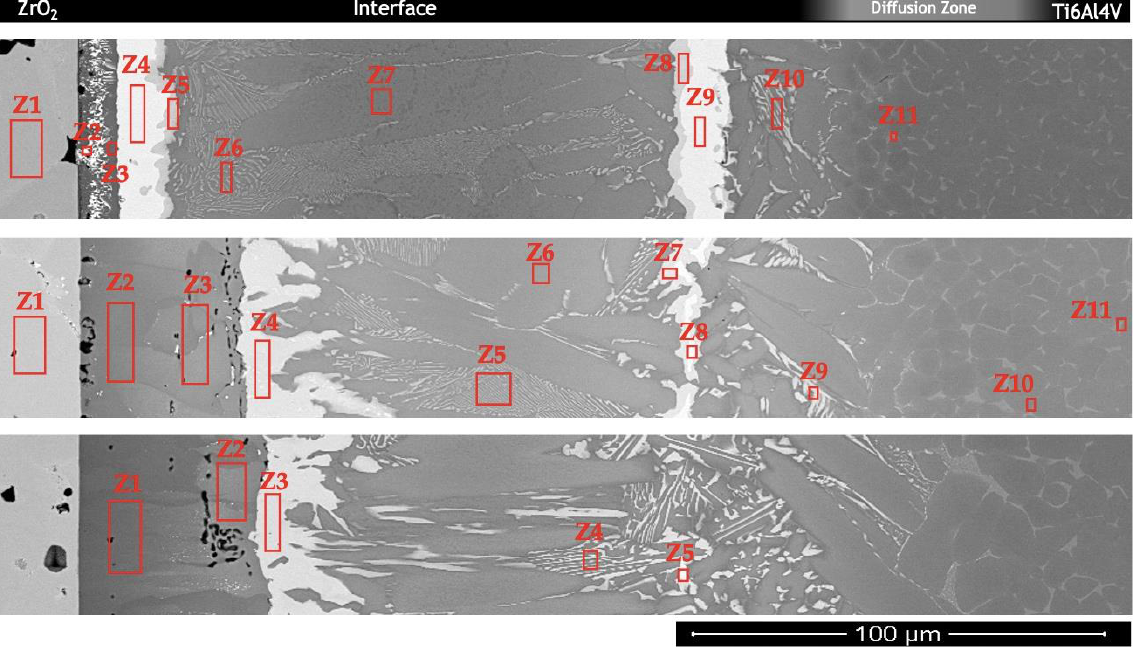
Figure 5. SEM images of ZrO 2 /Ti6Al4V alloy interfaces obtained at 900, 950, and 980 °C with indi- cation of the EDS analyzed zones.